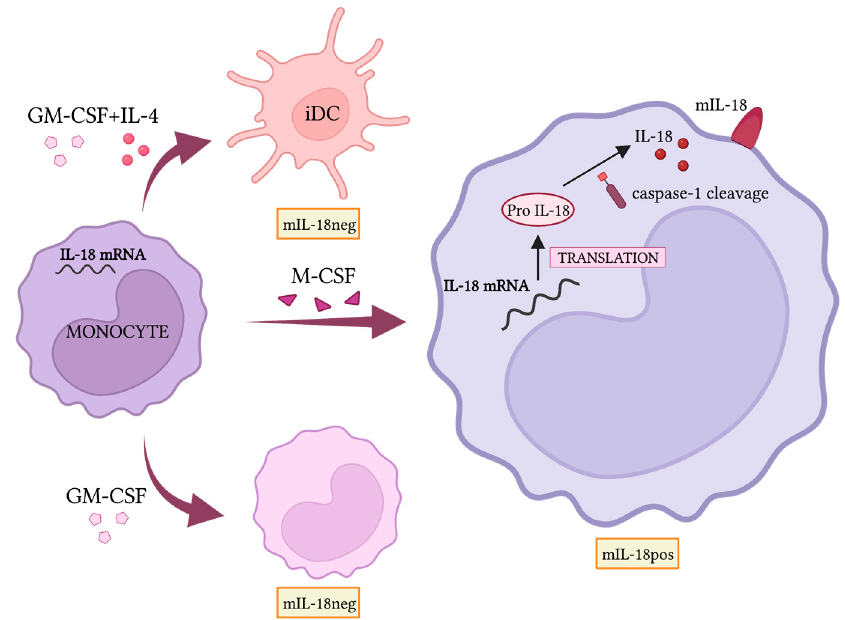
Figure 2. Mechanisms allowing mIL-18 expression. Monocytes from peripheral blood of healthy donors don’t express mIL-18, although IL-18 mRNA and pro-IL-18 is detected. Monocyte treatment with GM-CSF or their differentiation toward DCs (GM-CSF + IL-4) doesn’t result in mIL-18 expression. On the contrary, the M-CSF-induced monocyte differentiation toward macrophages is accompanied by mIL-18 expression in a subpopulation (30–40%) of unpolarized macrophages Created with BioRender.com (accessed on 12 February